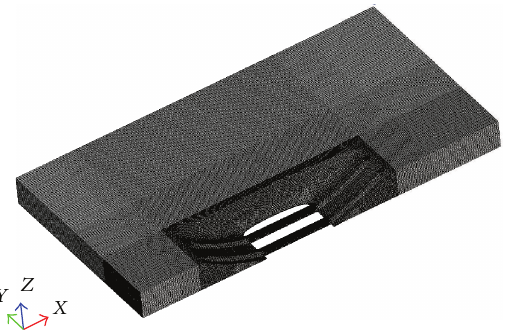
Figure 14: Hydroplaning computational domain mesh. Table 4: Comparison of outlet flow at different speeds.